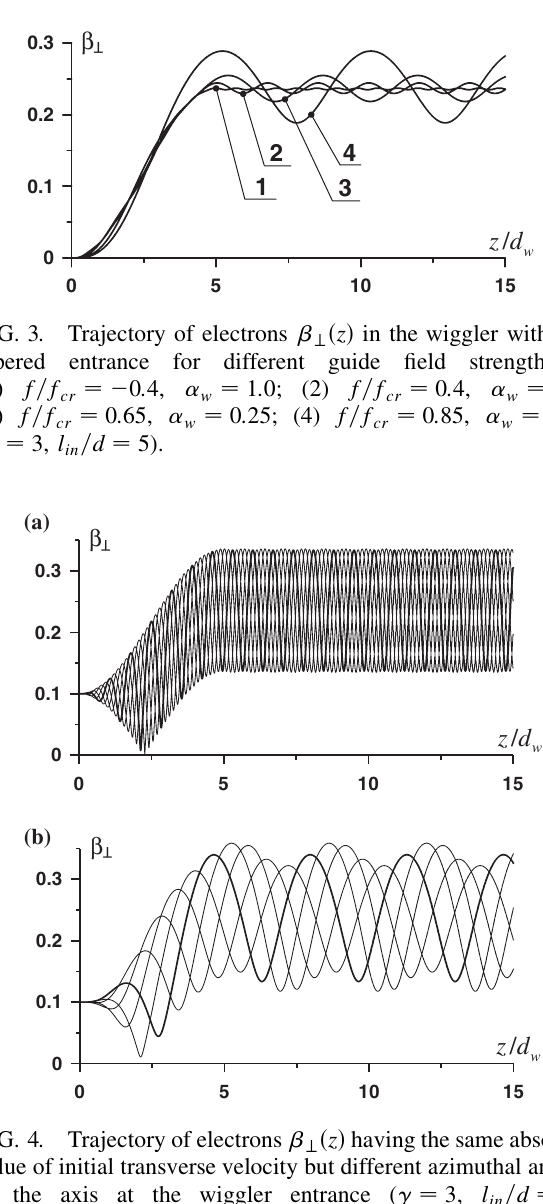
=d ¼ 5 ): in ¼ 0 : 65 , (cid:4) ¼ 0 : 25 cr w